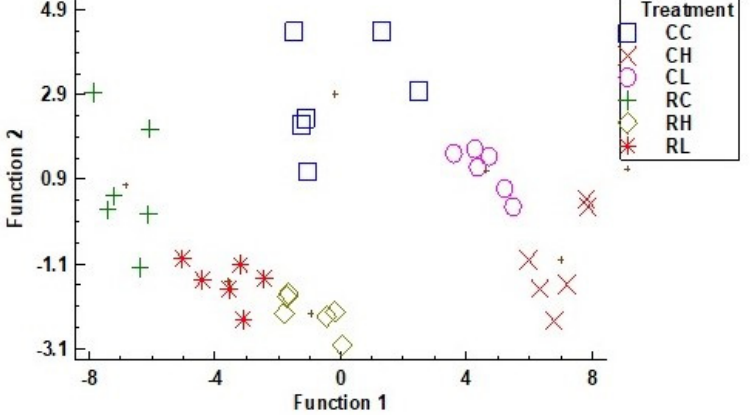
Figure 5. Discriminant analysis plot of the effect of salt treatments on strawberry cvs. Camarosa and Rociera growth parameters and fruit physiological, quality, and biochemical characteristics.